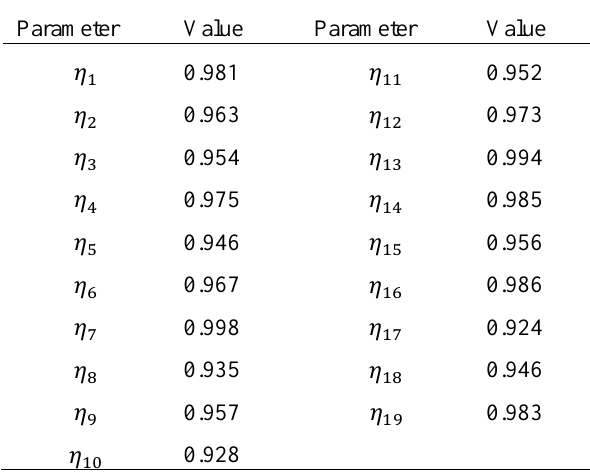
Fig. 5 . Interfacing scheme of LabVIEW with visual basic